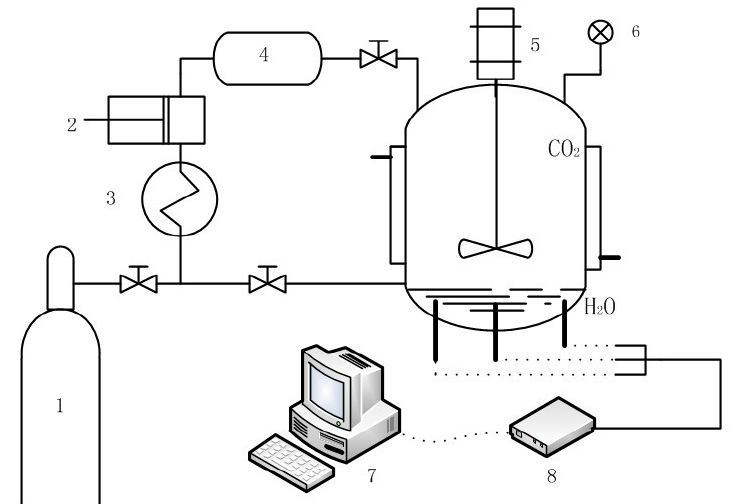
Figure 8. Experimental apparatus for CO pump; 3: CO liquefier; 4: liquid distributing cell; 5: high-pressure cell; 6: pressure gauge; 2 7: PC; 8: data collector.